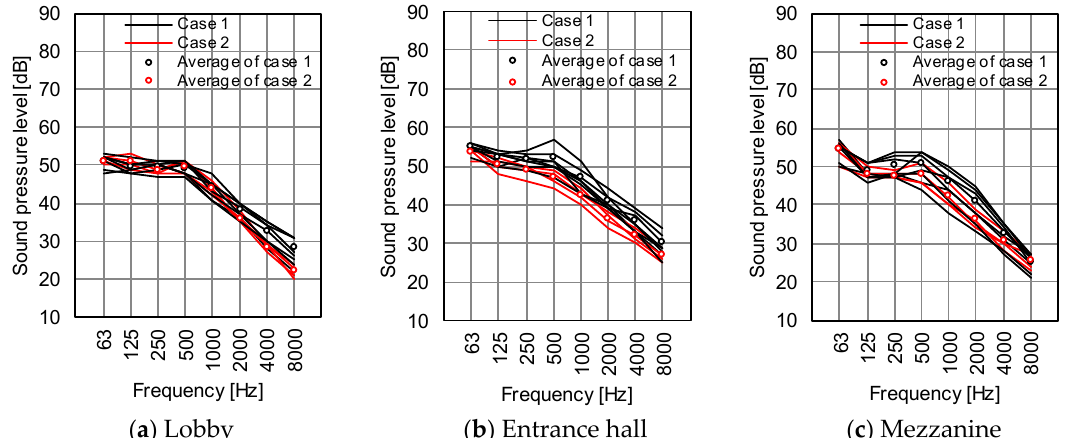
Figure 7. Frequency characteristics of the sound pressure levels during hotel operations in each room: ( a ) the lobby, ( b ) entrance hall, and ( c ) mezzanine. Case 1 is a crowded situation, and case 2 is less crowded.